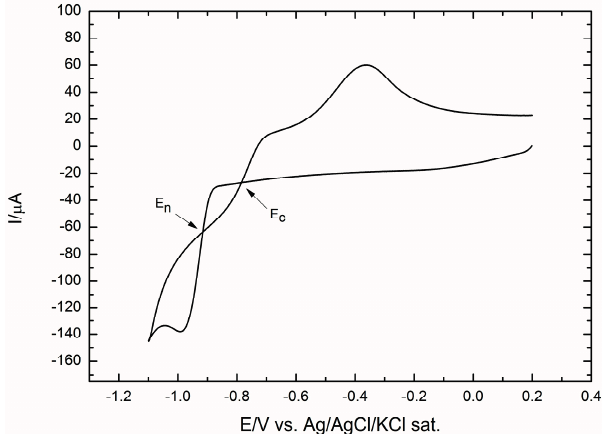
Figure 1. Linear sweep voltammograms for Co deposition from Co(II) (5 × 10 − 3 M)